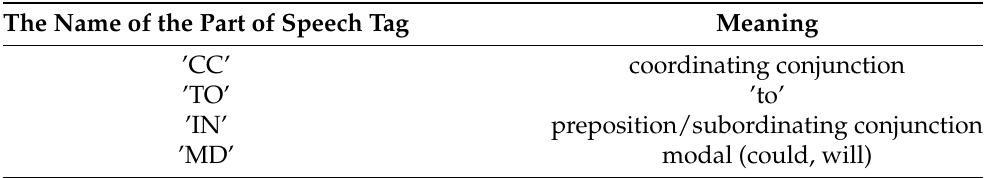
Table 1. The meaning of the filtered part of speech tag.